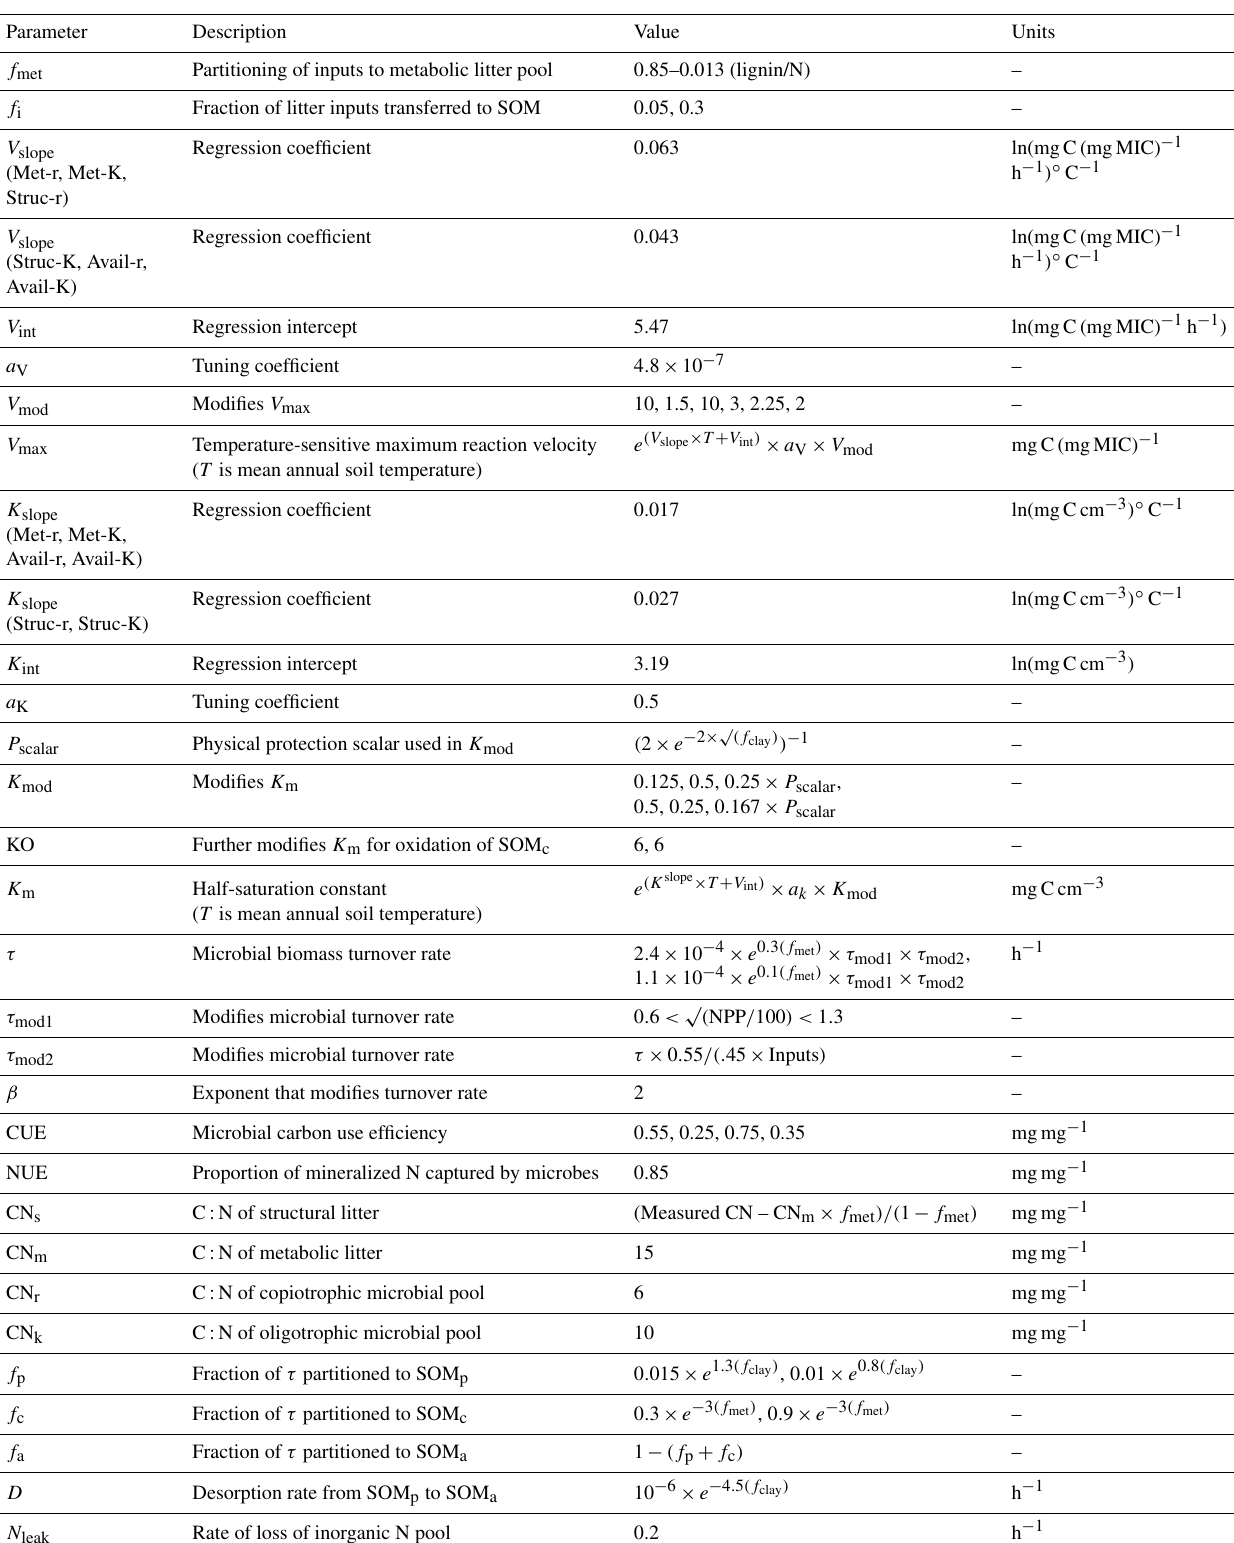
Table 1. Parameters used in MIMICS-CN for both LIDET and equilibrium simulations.